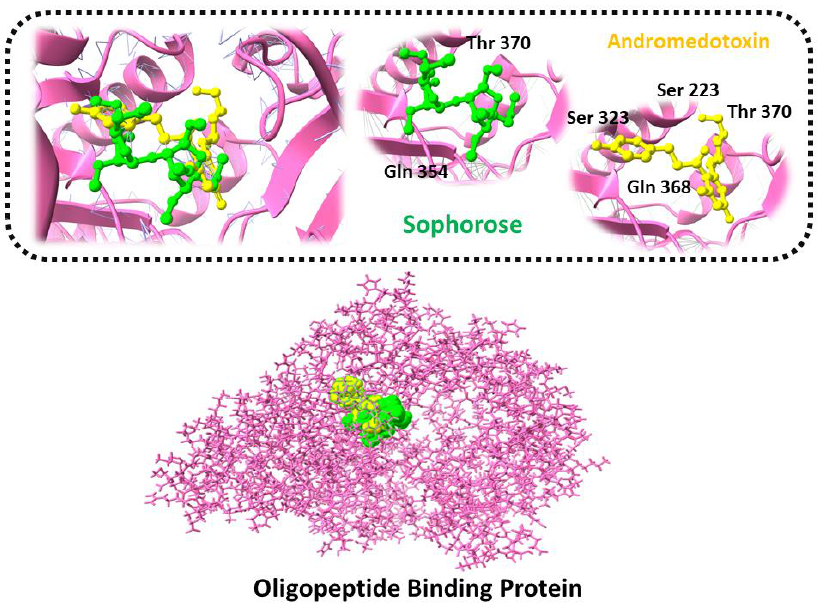
Figure 5. Three-dimensional representation of molecular docking analysis and the interaction of Andromedotoxin and Sophorose inhibitors with Oligopeptide Binding Protein.